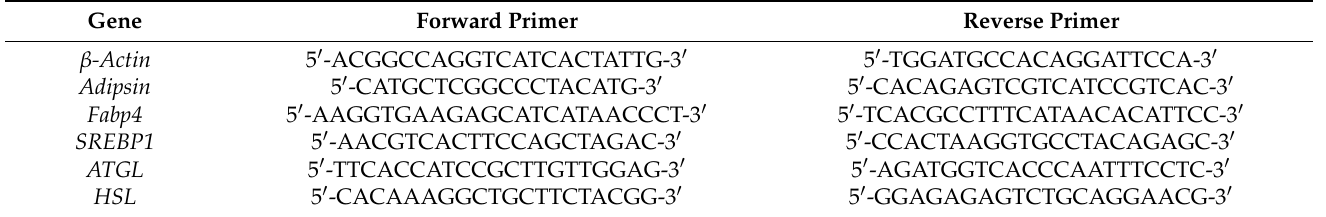
Table 2. Sequences of the primers used for quantitative reverse transcription-polymerase chain reaction (RT-qPCR). Gene Forward Primer